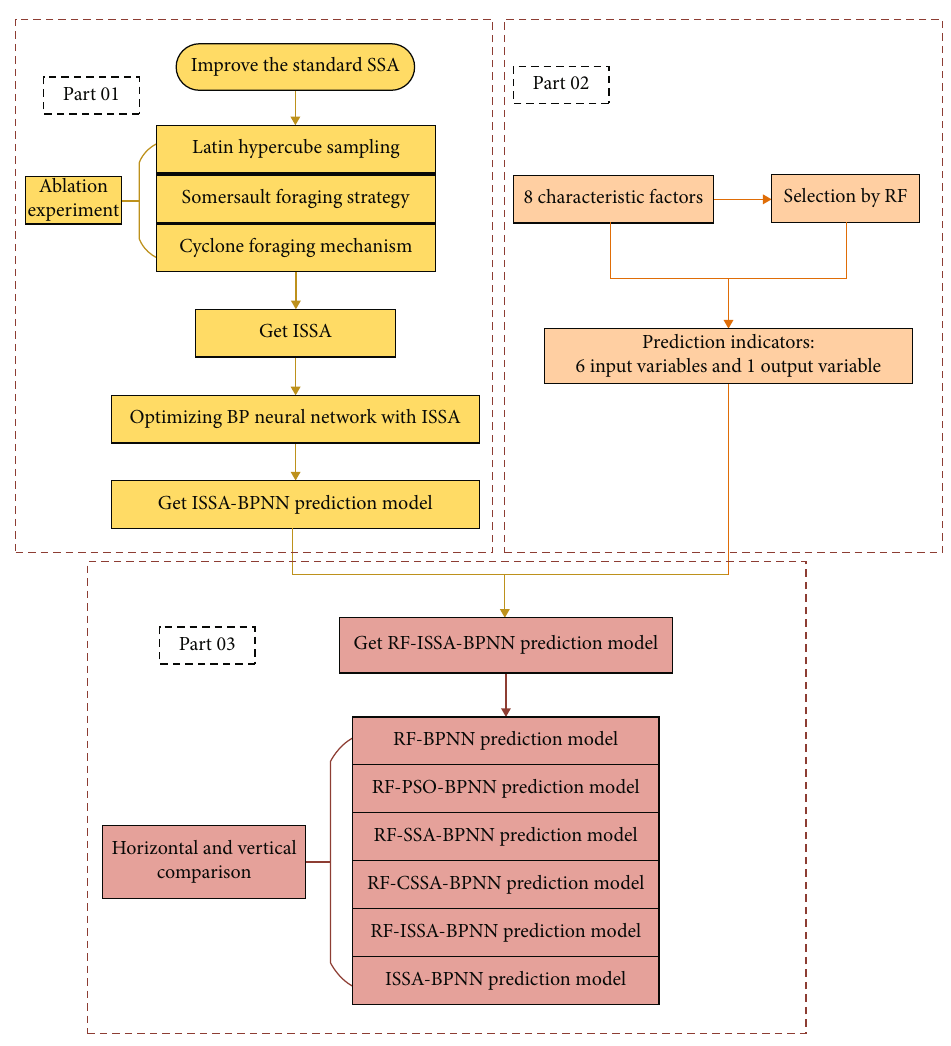
Figure 1: Brief fl ow chart of this research